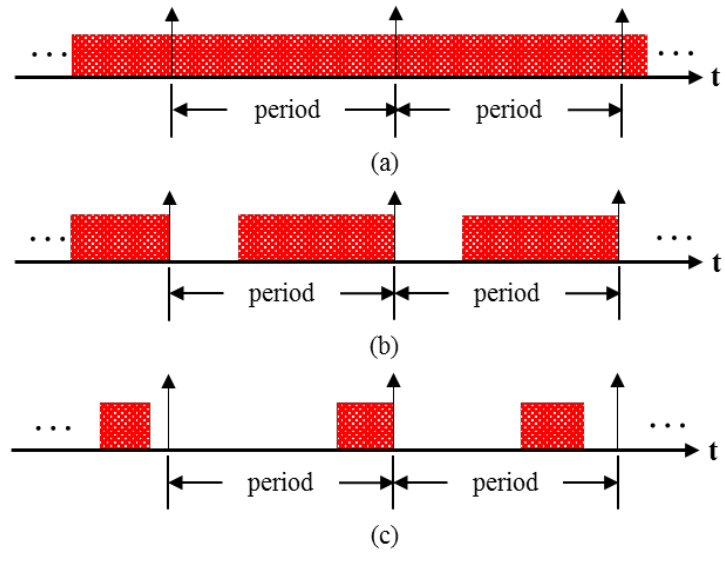
2. Timing diagrams of power supply methods for preheating sensors. ( a ) Continuous power supply method; ( b ) Constant power supply/cutoff method; ( c ) Power supply and cutoff by APC method.